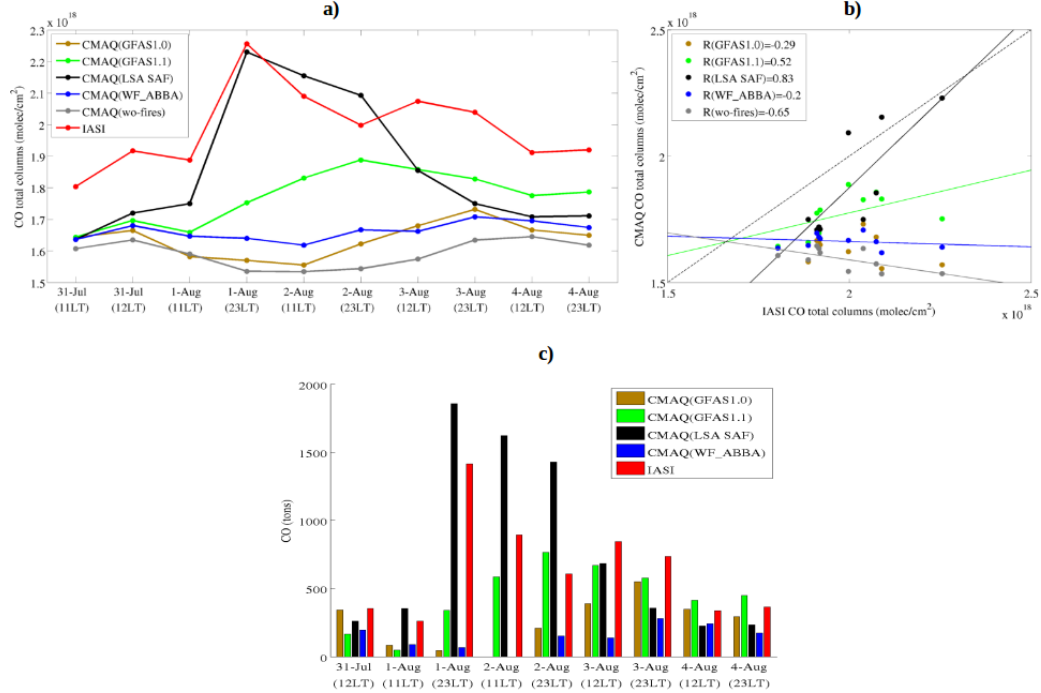
Figure 12. (a) Temporal variations of modeled and observed CO total columns from 31 July to 3 August 2008 averaged over the area of study and (b) linear regression and associated Pearson’s R coefficients between modeled and observed CO total columns averaged over the same period and area. (c) Tons of CO emitted by the Antalya fire over the study area, as observed by IASI and simulated by CMAQ. The contribution of the Antalya fire on the CO observed and simulated has been evaluated by subtracting the minimum value of the respective time series in the upper-left panel. Five different simulations have been performed using various emission scenarios: CMAQ (GFAS1.0),